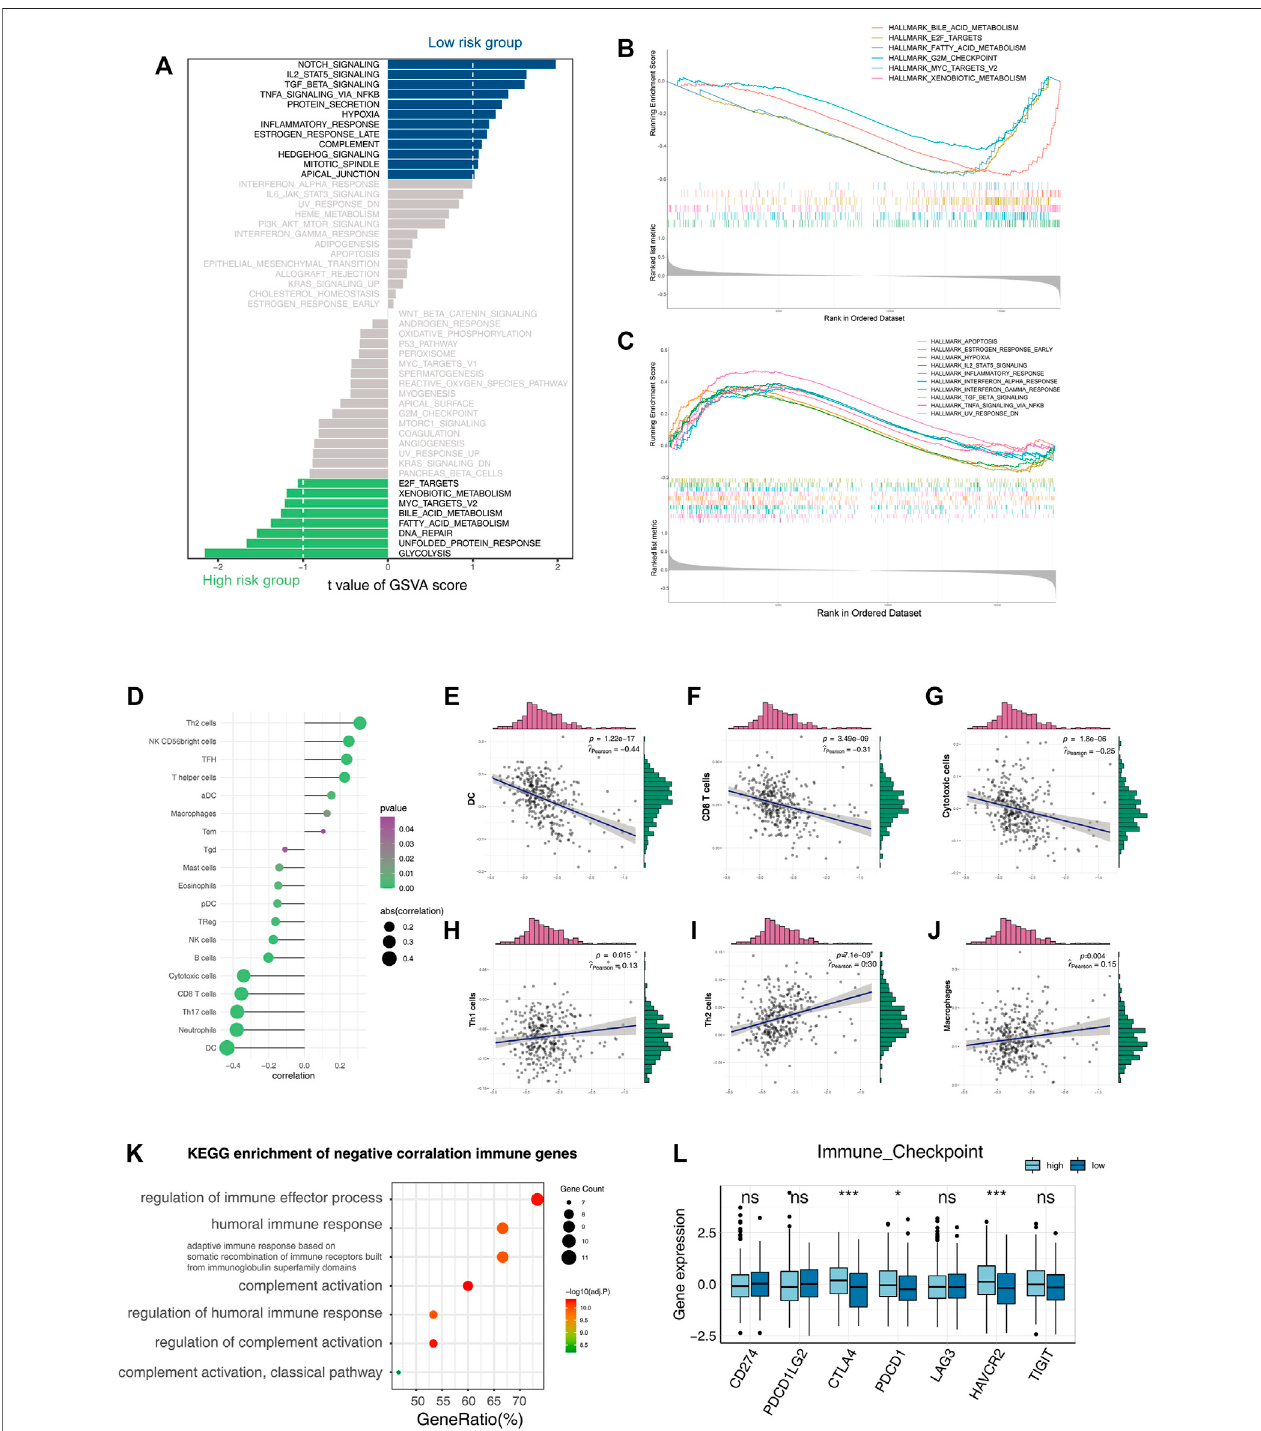
FIGURE 3 | Functional enrichment analysis of the three-gene signature. (A) Bar plot of GSVA enrichment in the high-risk group and low-risk group. (B,C) GSEA enrichment results in the high-risk group and low-risk group. (D – J) Correlation of the risk score with in fi ltrative immune cells. (K) KEGG enrichment result of immune genes ’ negative correlation with risk scores. (L) Boxplot shows the expression of immune checkpoints in the high-risk group and low-risk group (* p < 0.05, ** p < 0.01, and *** p < 0.001).